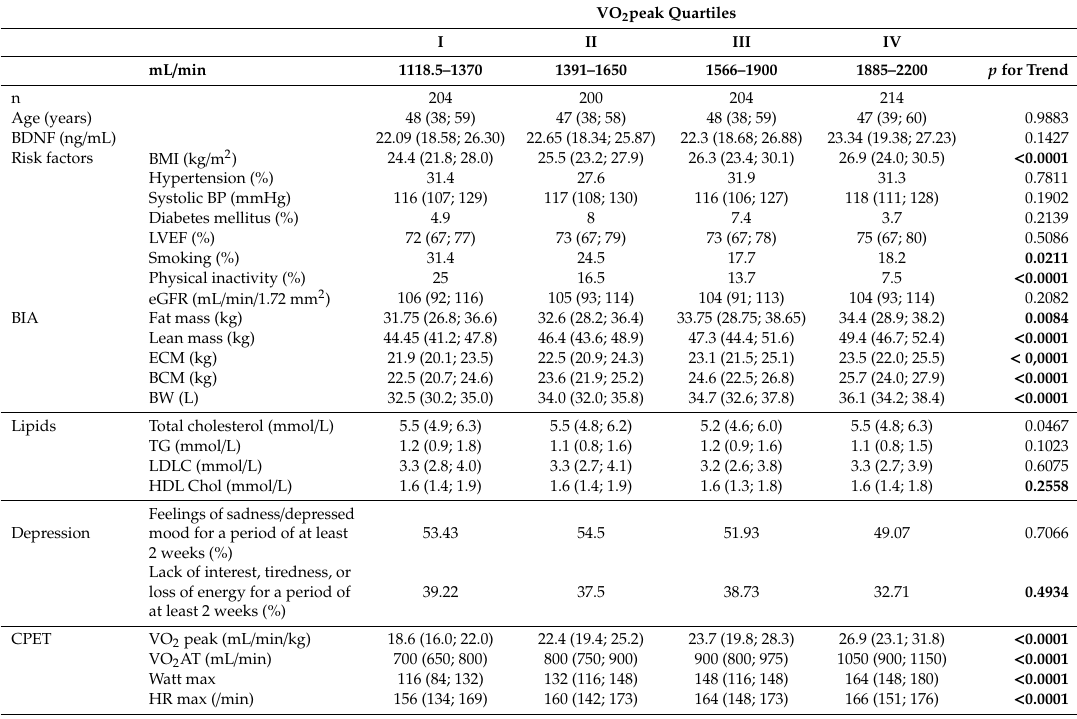
Table 2. Population descriptions according to VO 2 peak quartiles for